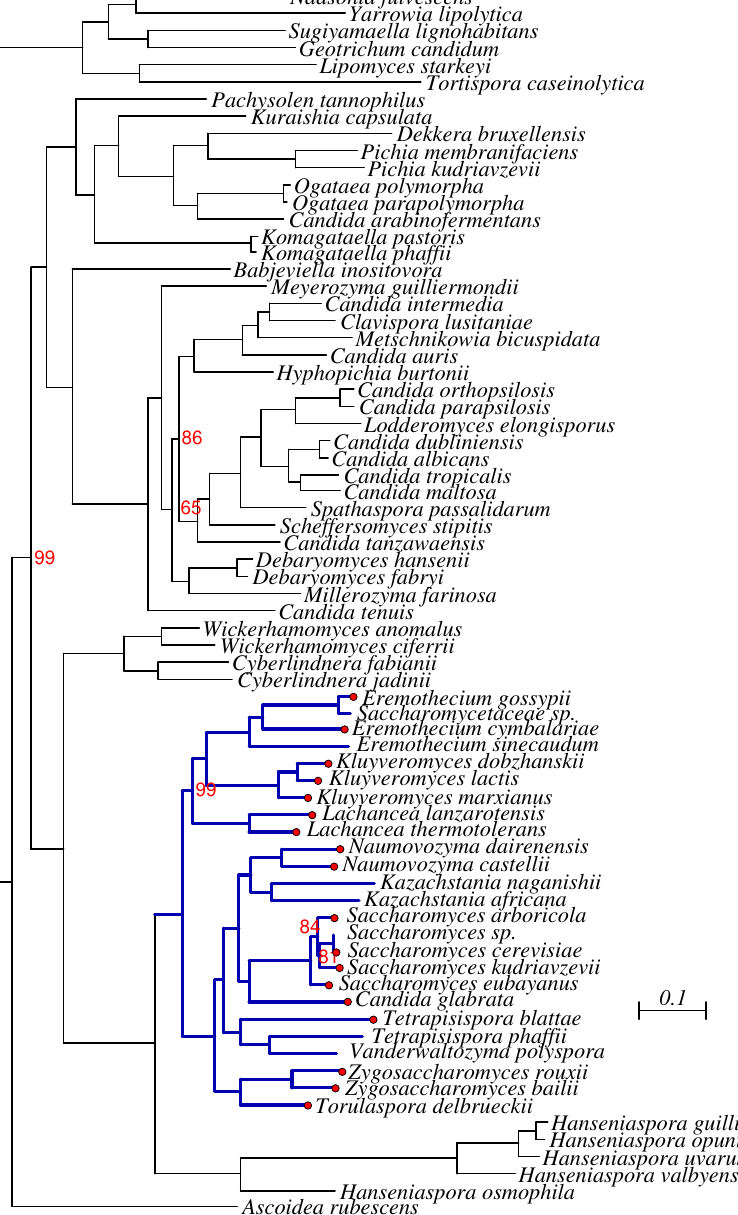
Figure A1. Phylogeny of the Saccharomycetales. Bootstrap support is 100% unless otherwise indicated. The Saccharomycetacea are indicted in dark blue. A red dot at tip of the tree indicates a TER sequences listed in Table